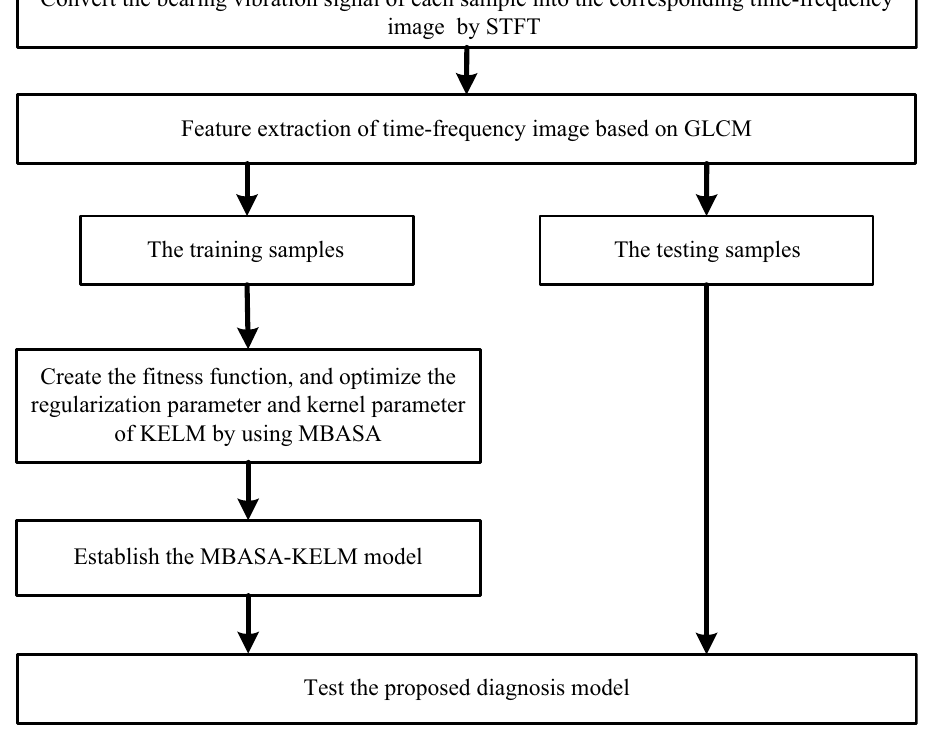
Figure 3. Fault diagnosis process of bearing based on GLCM and MBASA-based